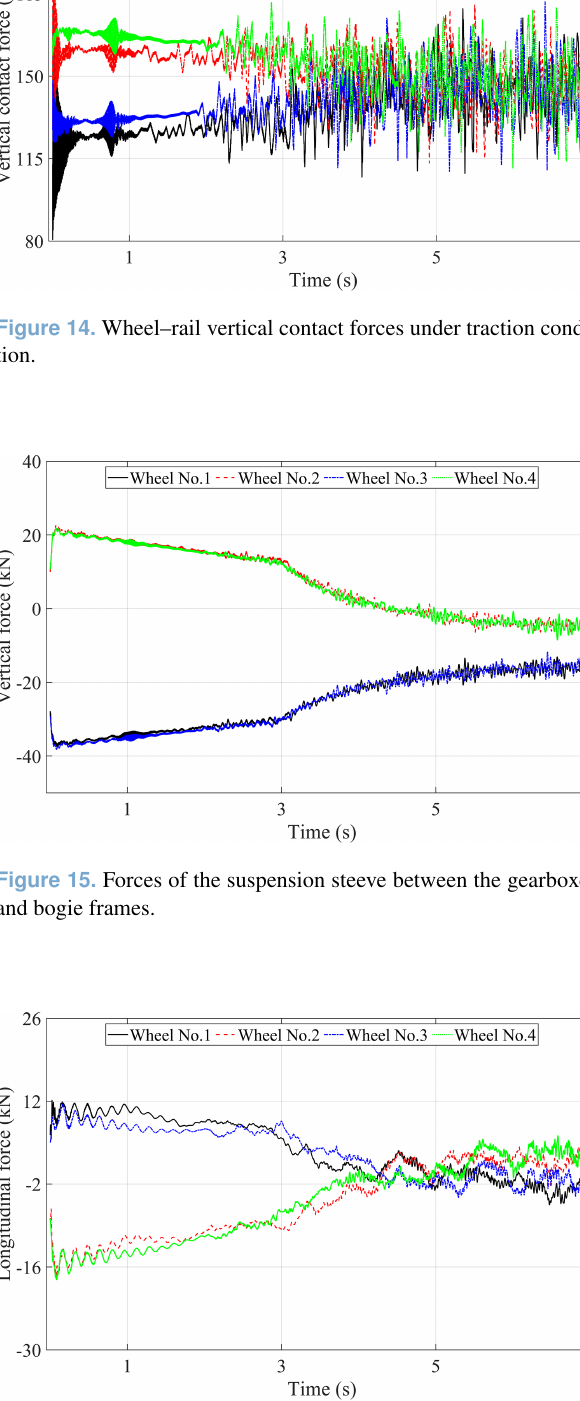
Figure 16. Longitudinal interaction forces between the traction mo- tors and bogie